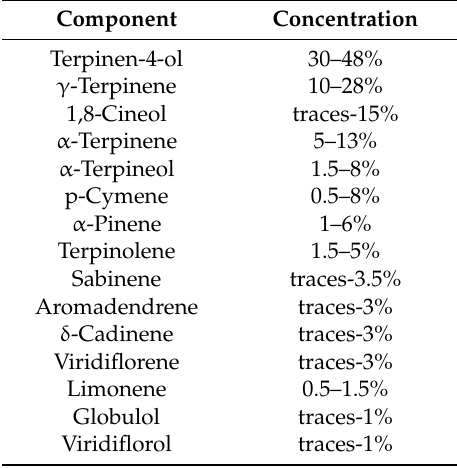
Table 2. ISO 4730 (2004)—Tea tree oil